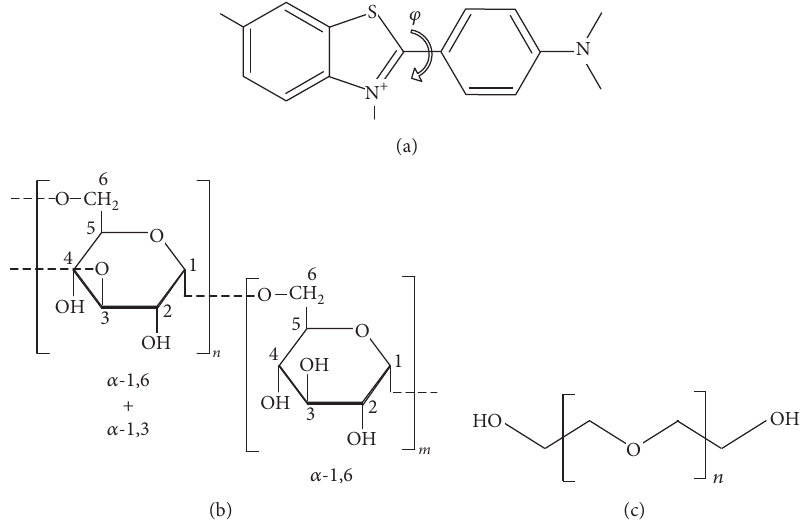
Figure 1: Structure of the fluorescent probe thioflavin T (ThT) and crowding agents. (a) ThT. The angle 𝜑 of internal rotation of benzothiazole and aminobenzene ringsof ThT relativeto each other isshown; (b) Dextran-70 (MW70000 Da). It isshown that thestraightchain of Dextran- 70 consists of 𝛼 -1,6 glycosidic linkages between glucose molecules, while branches begin from 𝛼 -1,3 linkages; 𝑚 : number of units (glucose molecules) with only 𝛼 -1,6 glycosidic linkages and 𝑛 : number of units with 𝛼 -1,6 and 𝛼 -1,3 linkages. ( c ) Polyethylene glycol (PEG). In the work we used PEG-400 and PEG-12000 with MW 400Da ( 𝑛 = 9 ) and MW 12000 Da ( 𝑛 = 272 ),